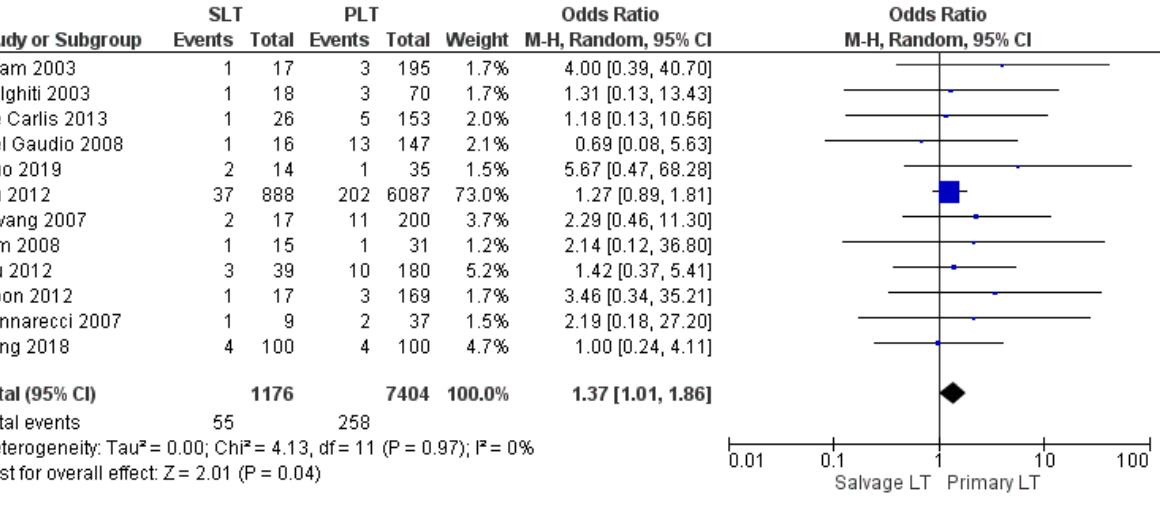
Figure 12. Overall vascular complication.